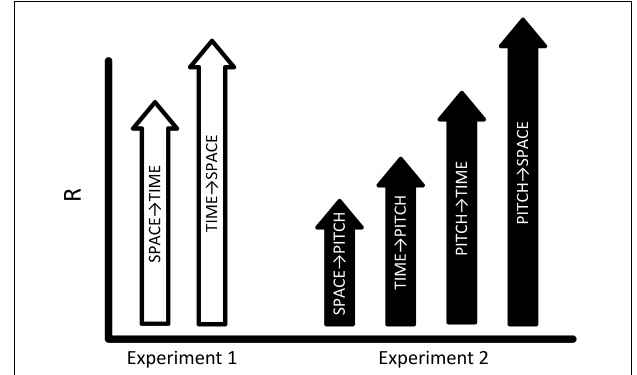
FIGURE 2 | Space, Time, and Pitch in Sound. Experiment 1 (white arrows) found that time and space are mutually contagious, with a larger effect of time on space (SPACE → TIME < TIME → SPACE; Rs, 0.88 < 0.98). Experiment 2 investigates relations between space, time, and pitch. If PITCH is more modality-relevant to auditory perception than TIME, and TIME is more relevant than SPACE then the pattern of results represented by the black arrows is predicted in Experiment 2. That is, Rs for each condition are expected to follow a pattern where the effects of SPACE → PITCH < TIME → PITCH < PITCH → TIME < PITCH →